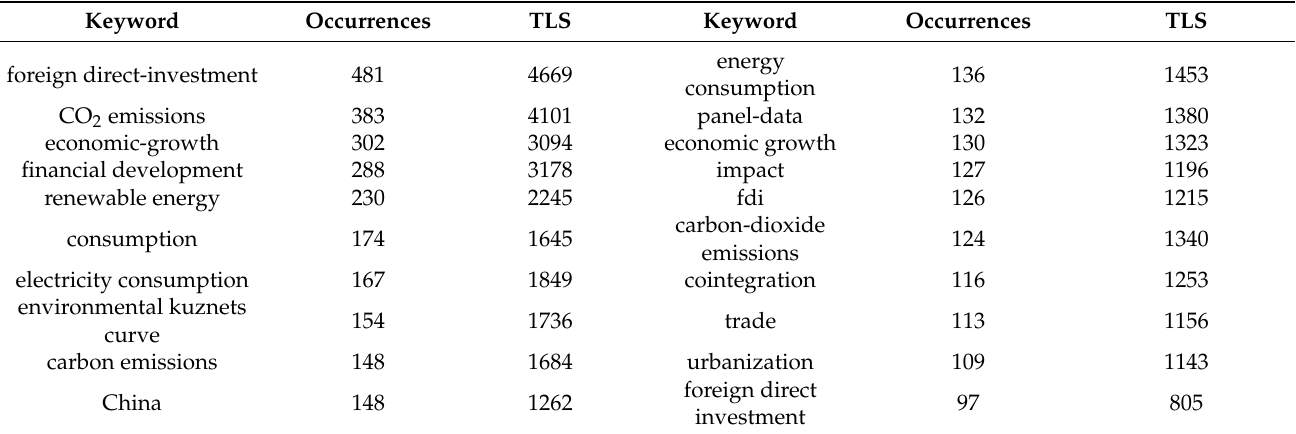
Table 3. The top 20 keywords occurred in Figure 6.